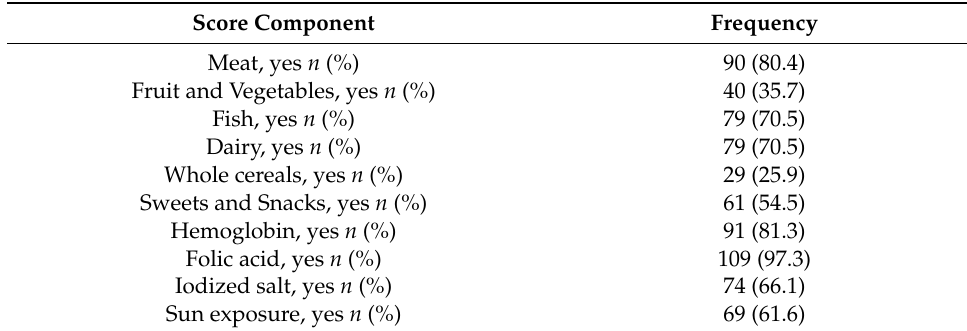
Table 1. Periconceptional nutritional score as a measure of maternal adherence to a healthy diet and healthy